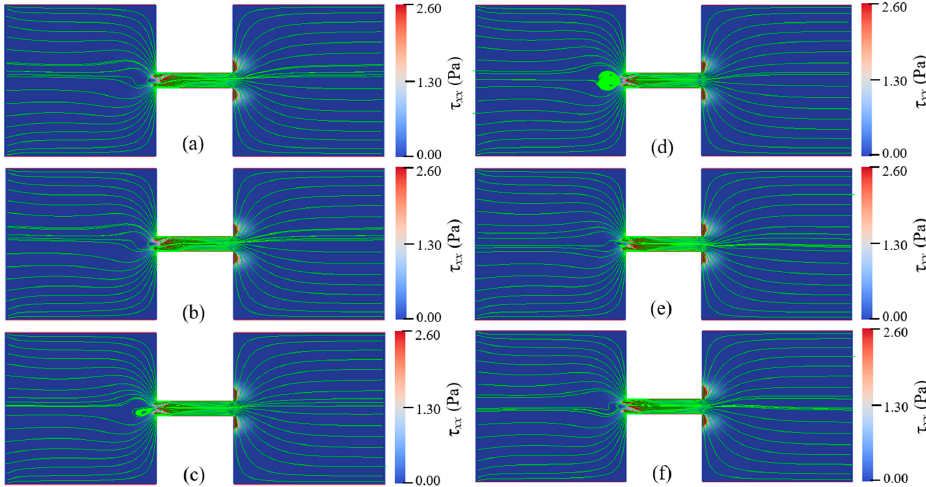
Figure A6. Streamlines of 150 ppm PAA solution under E app = 600 V/cm at different times: ( a ) 1.70 s, ( b ) 1.72 s, ( c ) 1.74 s, ( d ) 1.76 s, ( e ) 1.78 s, ( f ) 1.80 s. Zeta potential is − 150 mV. The color bar represents the elastic normal stress τ xx .